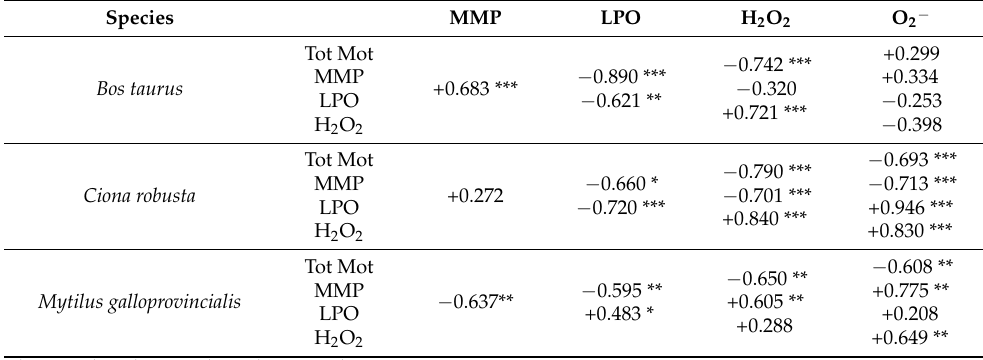
Table 2. Correlation coefficients (R) between sperm total motility (Tot Mot), mitochondrial membrane potential (MMP), lipid peroxidation (LPO), intracellular content of hydrogen peroxide (H 2 O 2 ) and of superoxide anions (O 2 − ) in the three species examined. Species MMP LPO H 2 O